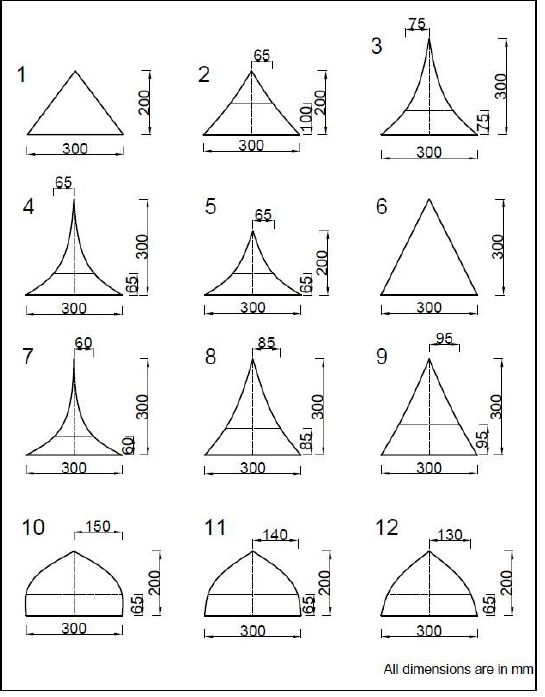
Figure 5. Various geometries adopted for optimization based on the cactus plant.